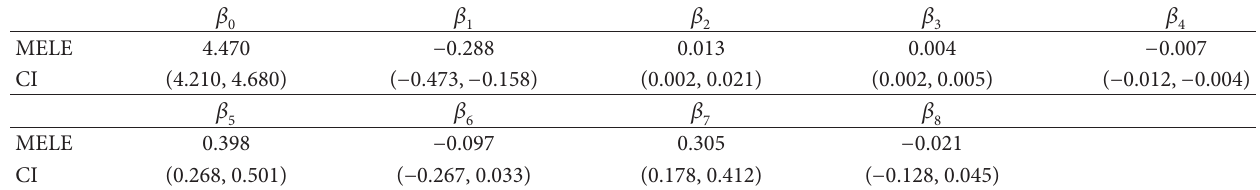
T 2: Application to CGD data. e maximum empirical likelihood estimators (MELE) and 95 parametric components based on the AEL